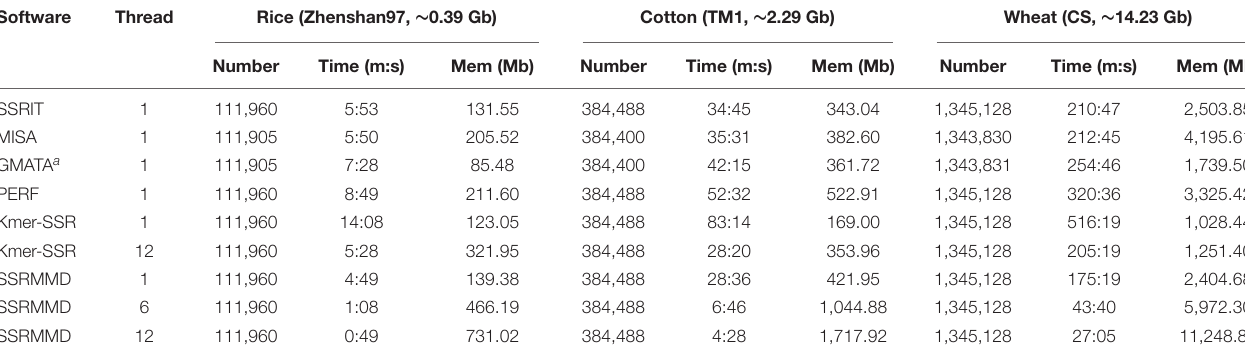
FIGURE 2 | Assessment of complexity and threads of Simple Sequence Repeat Molecular Marker Developer (SSRMMD). (A) The time complexity in mining SSR feature loci. (B) The space complexity in mining simple sequence repeat (SSR) feature loci. (C) Time complexity in developing polymorphic SSRs. (D) The space complexity in developing polymorphic SSRs. (E) The impact on time and space when increasing threads in mining SSR feature loci. (F) The impact on time and space when increasing threads in developing polymorphic SSRs. TABLE 2 | Performance comparison between SSRMMD and other software programs for identifying genome-wide SSR feature